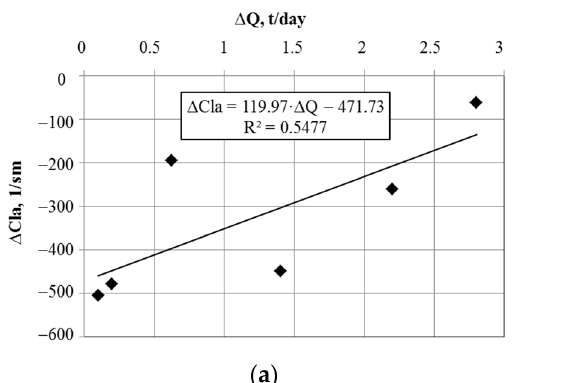
Figure 3. Change of water cut vs coefficient of light absorbance variation [100].